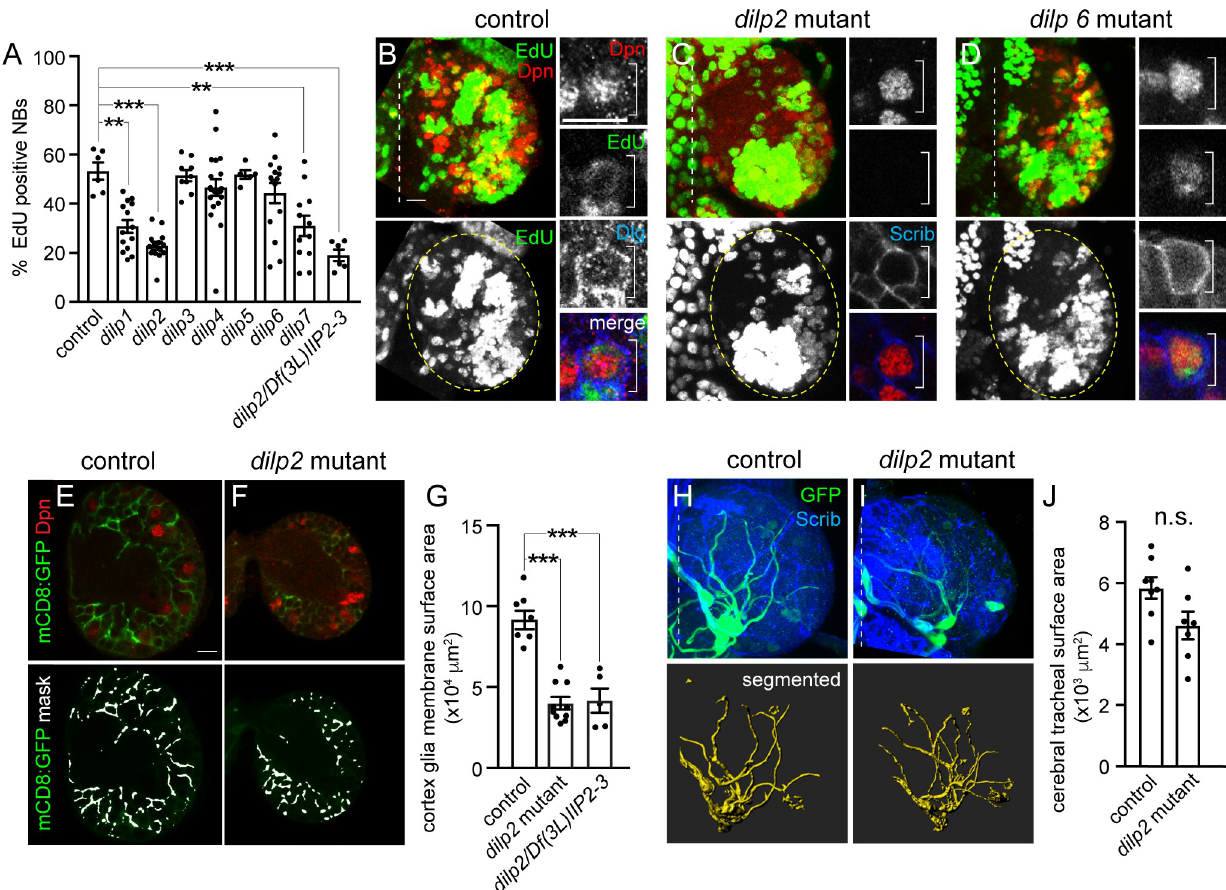
Fig 5. Dilp-2 regulates NB reactivation and cortex glial membrane growth. (A–D) EdU-positive NBs after 24 hours of feeding in dilp single-null– mutant animals with quantification (A) shown as a scatter plot with dots indicating brain hemispheres, bars indicating means, and error bars SEM. (B–D) Maximum intensity projections of brain hemispheres. Top panels are colored overlays with single-channel grayscale images below. Brain hemispheres are outlined, and dotted vertical lines indicate the midline. (E–G) Cortex glial membrane morphology after 24 hours of feeding in controls and dilp2 mutants. (E,F) Single Z images of brain hemispheres. Top panels are colored overlays, and bottom panels are single-channel images with the mask overlays used for quantification in (G). (H–J) Cerebral tracheal morphology after 24 hours of feeding in controls and dilp2 mutants. (H,I) Maximum intensity projections of brain hemispheres with rendered trachea below and quantified in (J). (A,G) One-way ANOVA with Tukey post hoc analysis and (J) Student two-tailed t test, � p < 0.05, �� p < 0.01, ��� p < 0.001. Genotypes of panels listed in S2 Table and data listed in S1 Data. Dilp, Drosophila insulin-like peptide; Dlg, discs- large; Dpn, Deadpan; EdU, 5-ethynyl-2 0 -deoxyuridine; GFP, green fluorescent protein; mCD8, membrane-targeted mCD8 antigen; NB, neuroblast; n.s., not significant; Scrib, Scribble. ventral nerve cord (VNC) [21–23]. However, neuroblasts located within different CNS regions, brain versus VNC, could have different requirements for reactivation based on neuro- blast intrinsic differences and/or differences in tissue architecture. To determine whether Dilp-6 regulates growth of other cell types within the brain, we assayed glial and tracheal sur- face area in dilp6 mutants after 24 hours of feeding. No differences were observed compared to controls (Fig 6A–6F). To determine whether Dilp-2 masks Dilp-6 function in the brain, we assayed neuroblast EdU incorporation and size in dilp2 , dilp6 double-mutant animals. After 24 hours of feeding, neuroblast EdU incorporation was reduced in dilp2 , dilp6 double mutants (approximately 15% EdU-positive neuroblasts) compared with dilp2 single mutants (approxi- mately 22% EdU-positive neuroblasts); however, this reduction was not statistically different (S5A and S5B Fig). Next, we assayed dilp2 and dilp6 transcript levels (Fig 6G and 6H), and